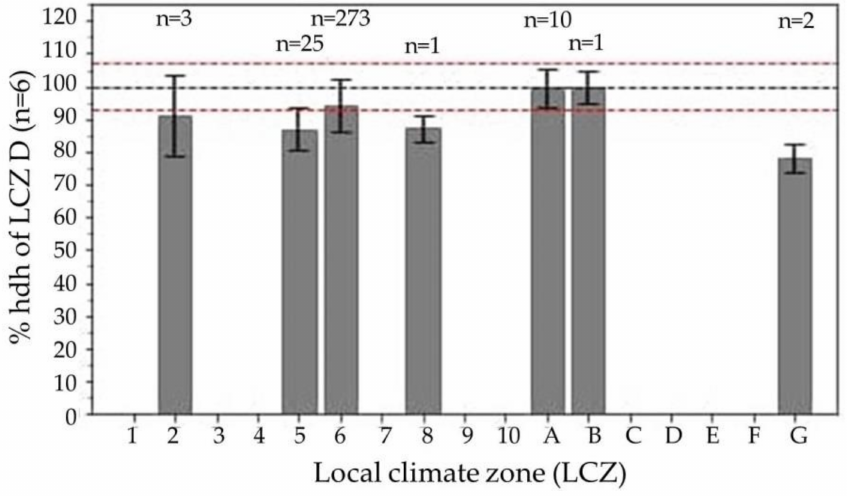
Figure 12. Mean heating degree hours in December 2018 for each LCZ, expressed as a percentage of × 100 , where LCZ x is the LCZ to be expressed the mean heating degree hours of LCZ D ( HDH LCZx HDH LCZD as a percentage of LCZ D). n represents the number of stations in each LCZ contributing to the mean. The red dashed line shows the error in the HDH calculation for LCZ D. Error calculations can be seen in Appendix